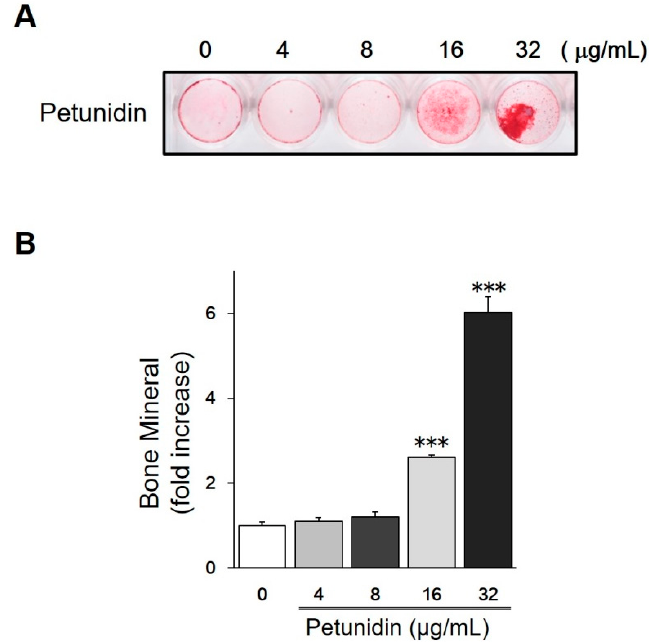
Figure 3. E ff ects of petunidin on in vitro osteoblastogenesis. ( A ) Representative photograph of mineralized nodule in MC3T3-E1 cells. Cells were treated with petunidin at the indicated concentrations for 16 days in di ff erentiation media supplemented with 50 µ g / mL ascorbate 2-phosphate, 10 mM β -glycerophosphate. At the end of incubation, cells were washed with PBS, fixed with 70% ethanol, and stained with Alizarin-red S. ( B ) Intensity of red stains of mineralized matrix measured using Molecular Imager ® (BioRad, Hercules, CA, USA). Values are expressed as mean ± SEM ( n = 4). *** p < 0.001 vs. control (0 µ g / mL of petunidin).